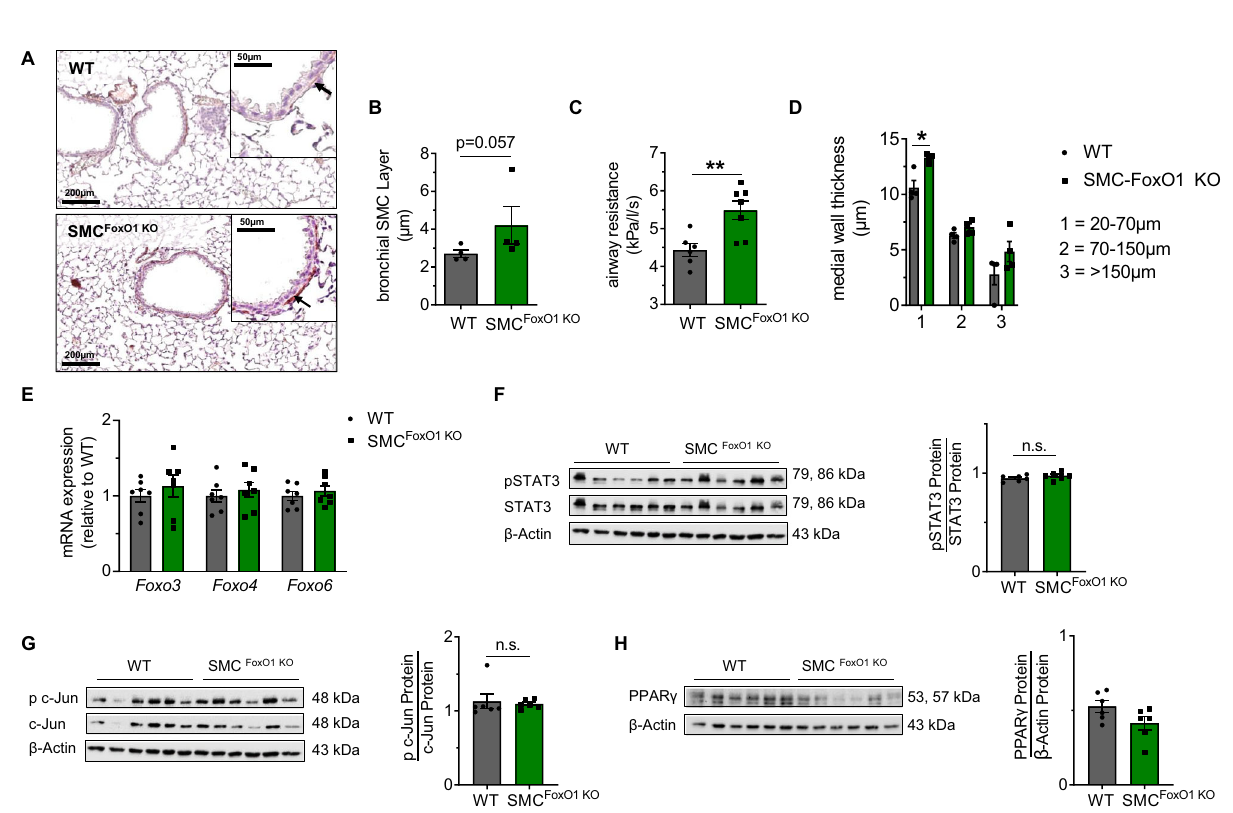
Fig. 8 Smooth muscle cell (SMC)-speci fi c ablation of FoxO1 induces airway resistance and vascular muscularization in mice. Genetically modi fi ed mice exhibiting a speci fi c ablation of FoxO1 in SMC (SMC FoxO1-KO ) were compared to the respective wild-type controls (WT). A Representative images for α - smooth muscle actin ( α SMA), an indicator of SMC, to assess the bronchial SMC layer. B Quantitative measurement of the SMC layer in the bronchi (diameter: 150 – 200 µ m) of adult mice. C Assessment of respiratory airway resistance in adult mice using body plethysmography. D Measurement of the medial wall thickness in pulmonary microvessels with diameters of 20 – 70 µ m, 70 – 150 µ m and >150 µ m. E Measurement of gene expression of Foxo3 , Foxo4 , and Foxo6 in total lung homogenates using qRT-PCR at P70; β -actin served as housekeeping gene; the expression is shown relative to WT and WT is set 1. F – H Immunoblots for pSTAT3 and total STAT3 ( F ), p c-Jun and total c-Jun ( G ), and PPAR γ ( H ) in total lung homogenates of WT and SMC FoxO1KO ; β